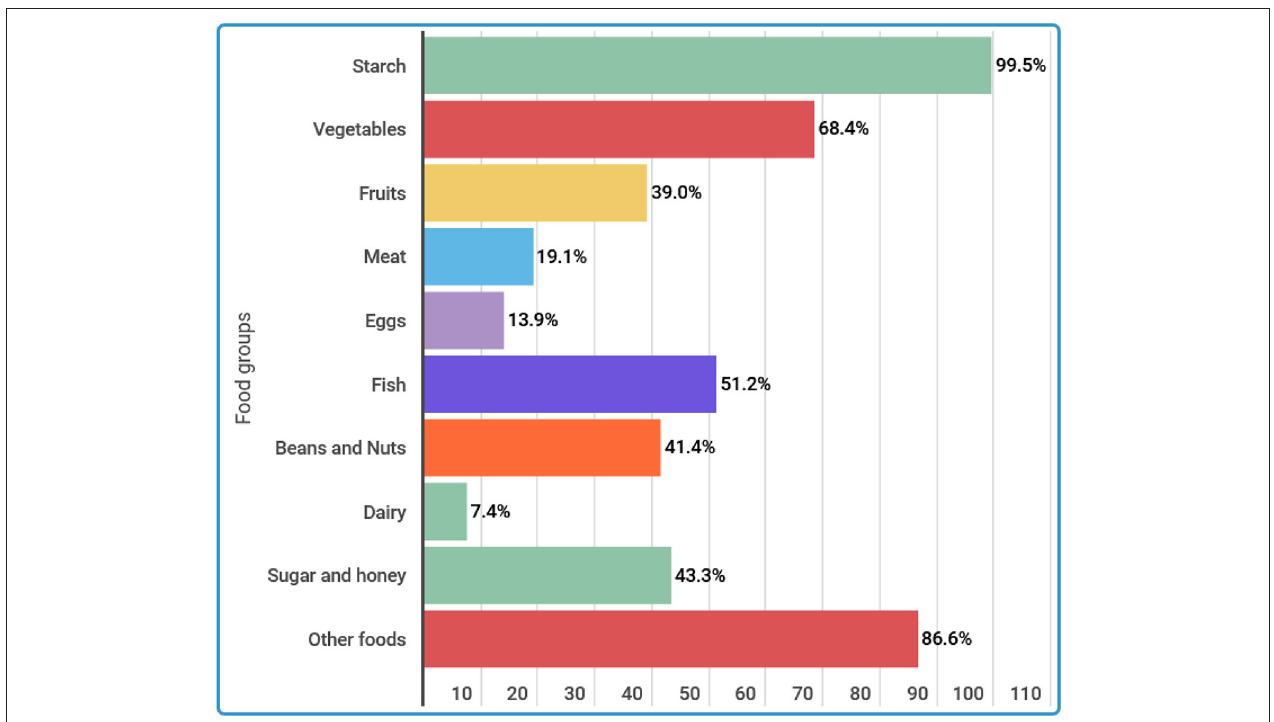
FIGURE 1 | Type of food consumed by women within 24h before the interview.